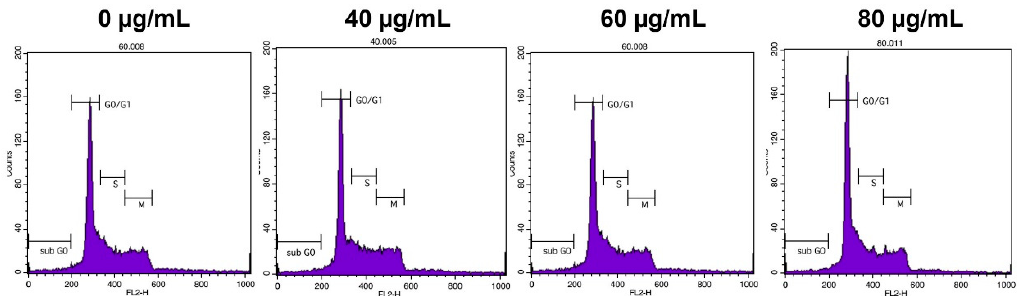
Figure 5. Effect of YLE on the cell cycle of HepG2 cells. The figure represents triplicate experiments.